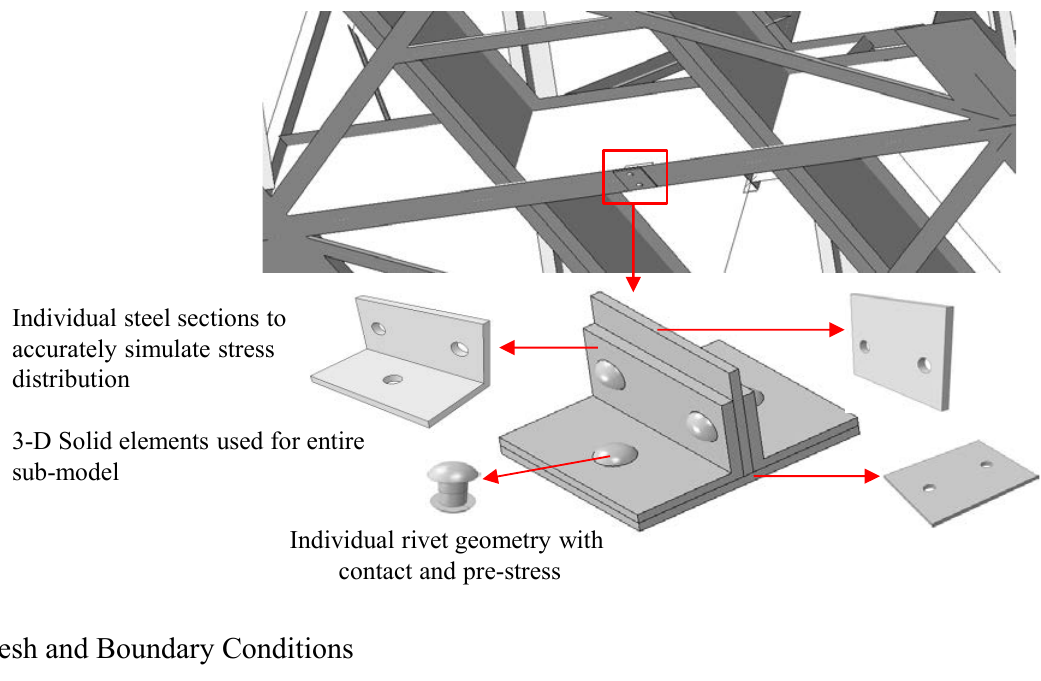
Figure 9. Riveted joint sub-model geometry, location and element